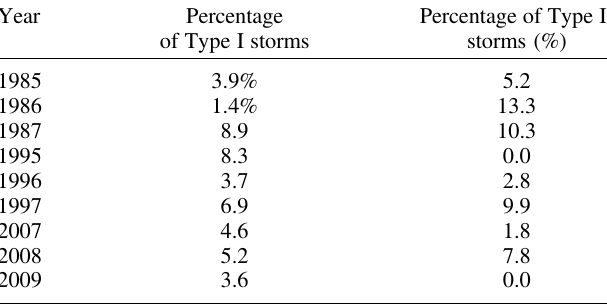
Table 3. Percentage of Type I ionospheric storms and Type II ionospheric storms observed by the AIS-INGV ionosonde at the Ionospheric Observatory of Rome during the minimum of solar activity at the turn of solar cycles 21 – 22, 22 – 23 and 23 –